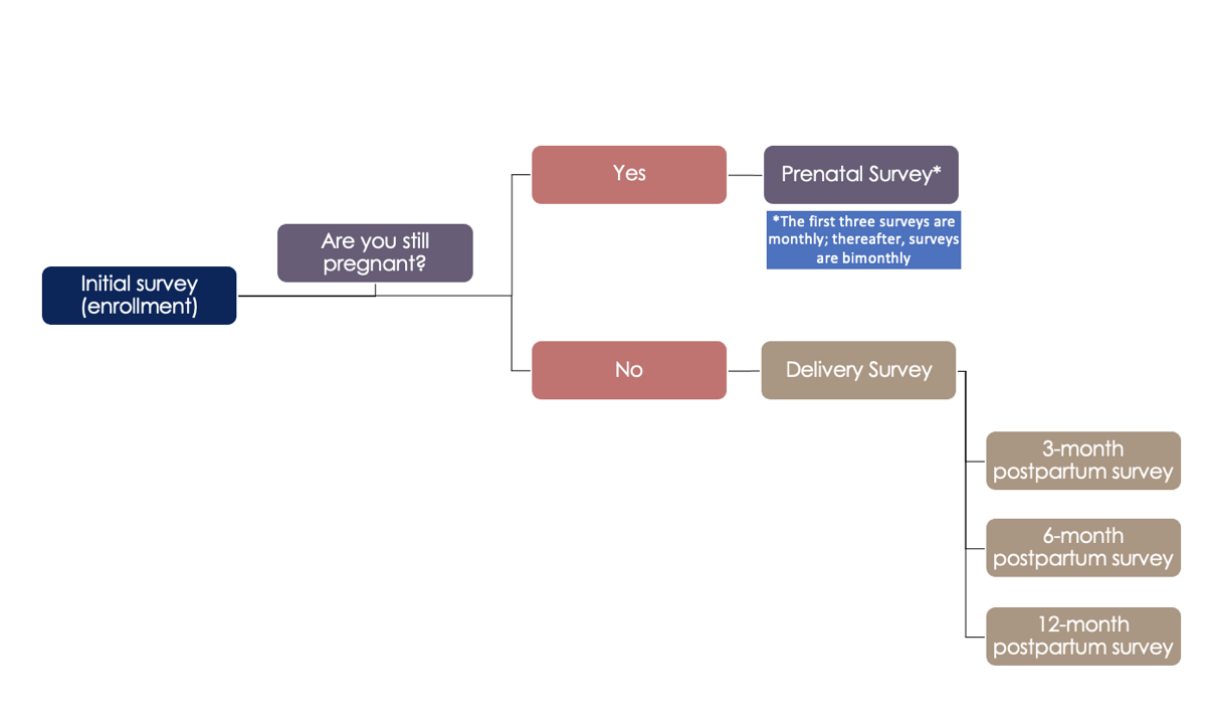
Figure 2. Study flow